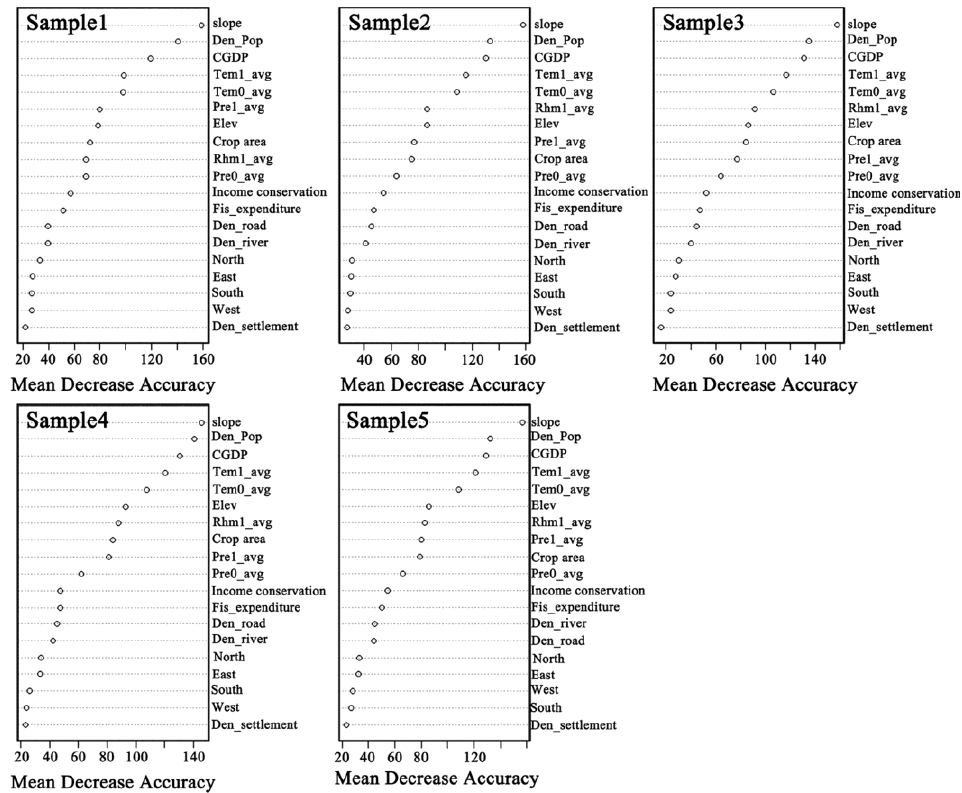
Figure 3. Plots of the variable importance measure for five samples. Note: the abbreviated variable names are the same as in Table 1.